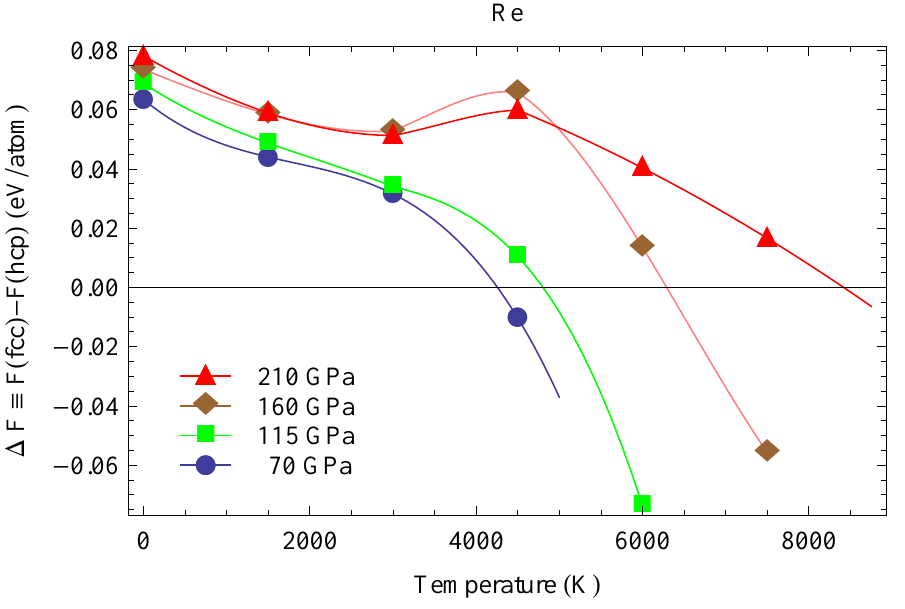
Figure 14. The hcp-Re–fcc-Re full free energy differences as functions of T at four pressures.